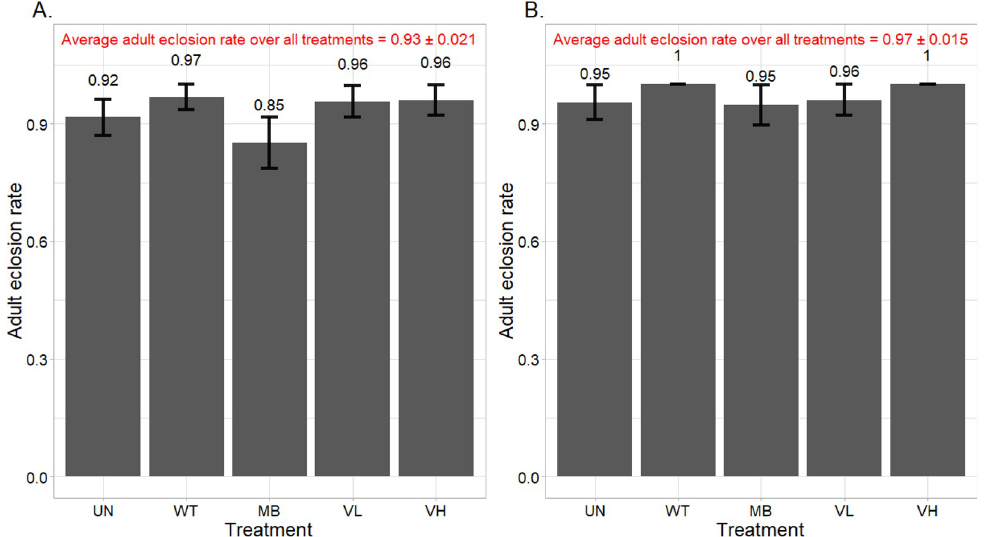
Fig 4. Average monarch adult eclosion rates of uninfected pupae in each treatment (data combined over all bioassay runs). Larvae were fed common (A) or tropical (B) milkweed leaves that were untreated (UN), treated with deionized water (WT), 5 mg/mL monarch-active dsRNA solution (MB), or 2.1 (VL) and 21 (VH) mg/mL Varroa-active dsRNA solutions. Bars represent the mean ± standard error.